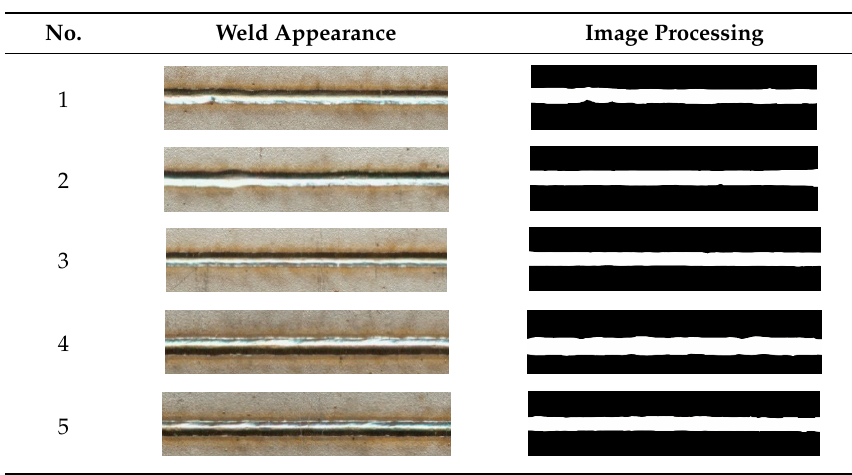
Table 3. Weld bead of No. 1 to No. 5 specimens.